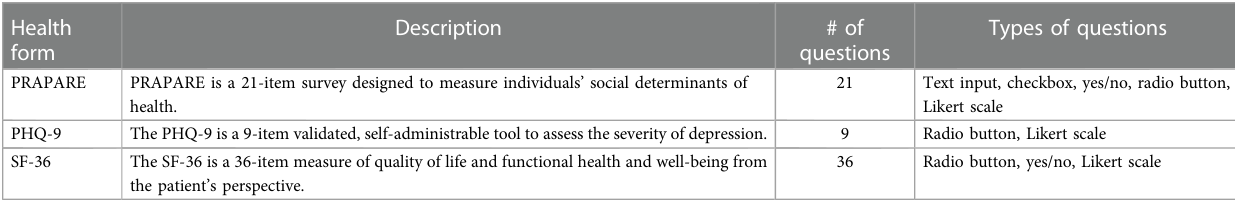
TABLE 1 Health forms used in the